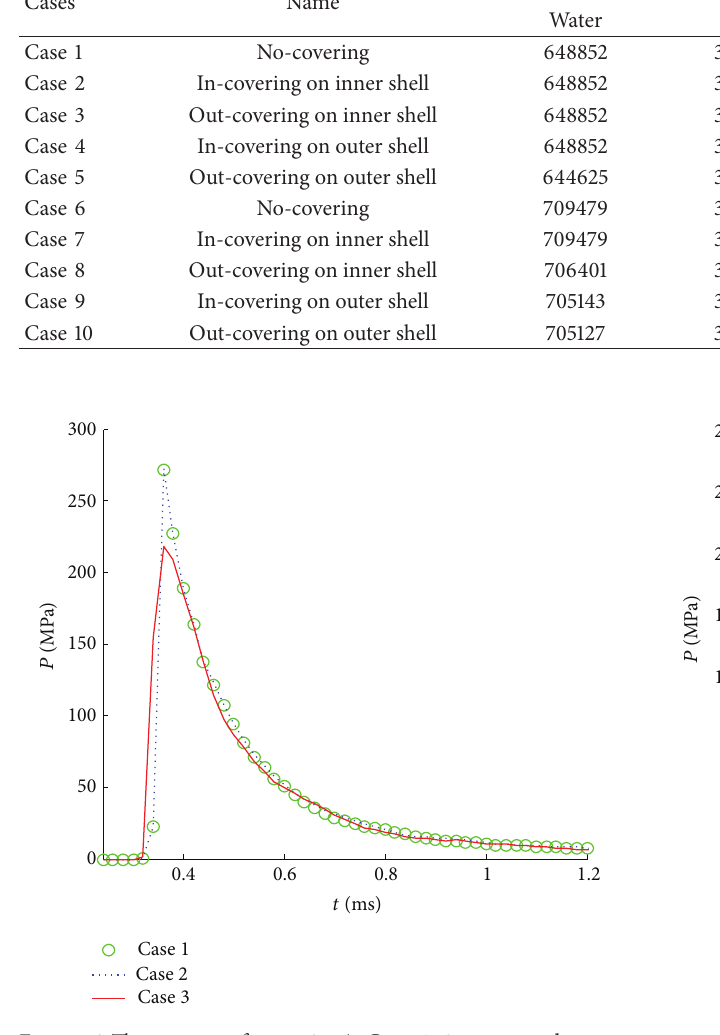
Figure 6: The pressure of test point A; Cases 1 – 3 correspond to no- covering, in-covering, and out-covering.